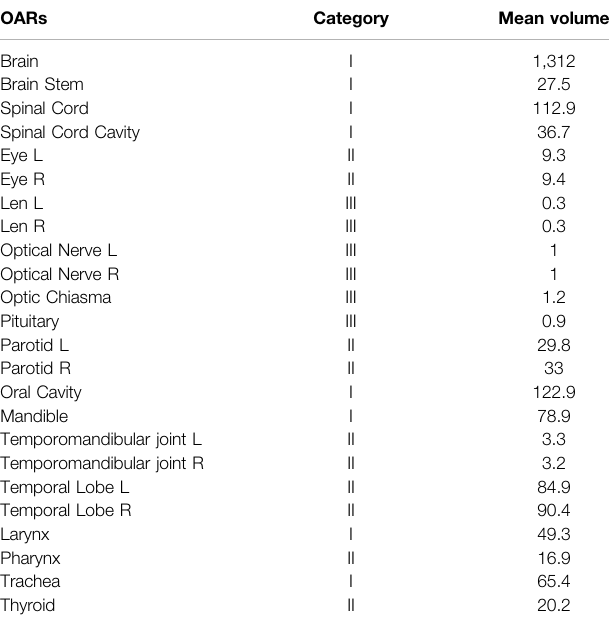
TABLE 1 | Statistical table of organs at risk (volume unit: cm 3 ). OARs